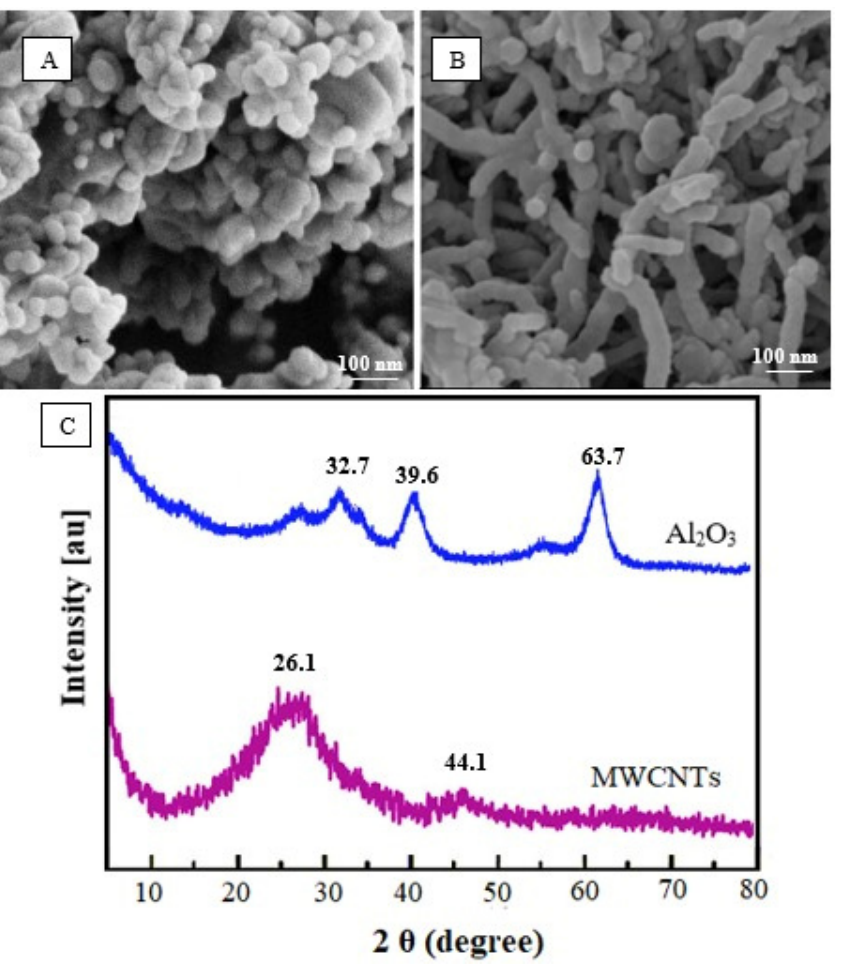
Figure 1. Characteristics of the nanoparticle additives: ( A ) SEM image of Al 2 O 3 NPs; ( B ) SEM image of MWCNTs, and ( C ) XRD patterns of Al 2 O 3 NPs and MWCNTs.